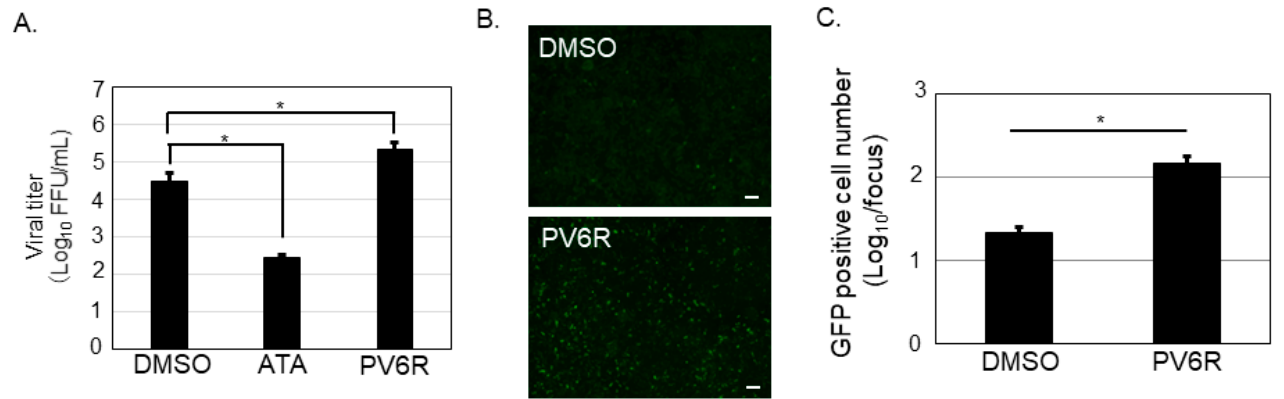
Figure 3. ATA, but not PV6R, inhibited LCMV production. ( A ) Culture supernatant of the Vero 76 cells infected with 3rLCMV/GFP and treated with DMSO, ATA (500 µ M), or PV6R (200 µ M), were used to measure the viral titer. ( B , C ) 3rLCMV/GFP and Vero 76 cells were pre-treated with PV6R (200 µ M) and allowed for the infection. PV6R was not included in the culture media after the infection. At 20 h post infection, the cells were fixed and the GFP positive cells were observed with the fluorescent microscope. Bar; 200 µ M ( B ). Counted GFP positive cells were plotted from both DMSO and PV6R treatments ( C ). Data were collected from at least three independent experiments, and shown data correspond to the mean +/ − SD (* p < 0.05).